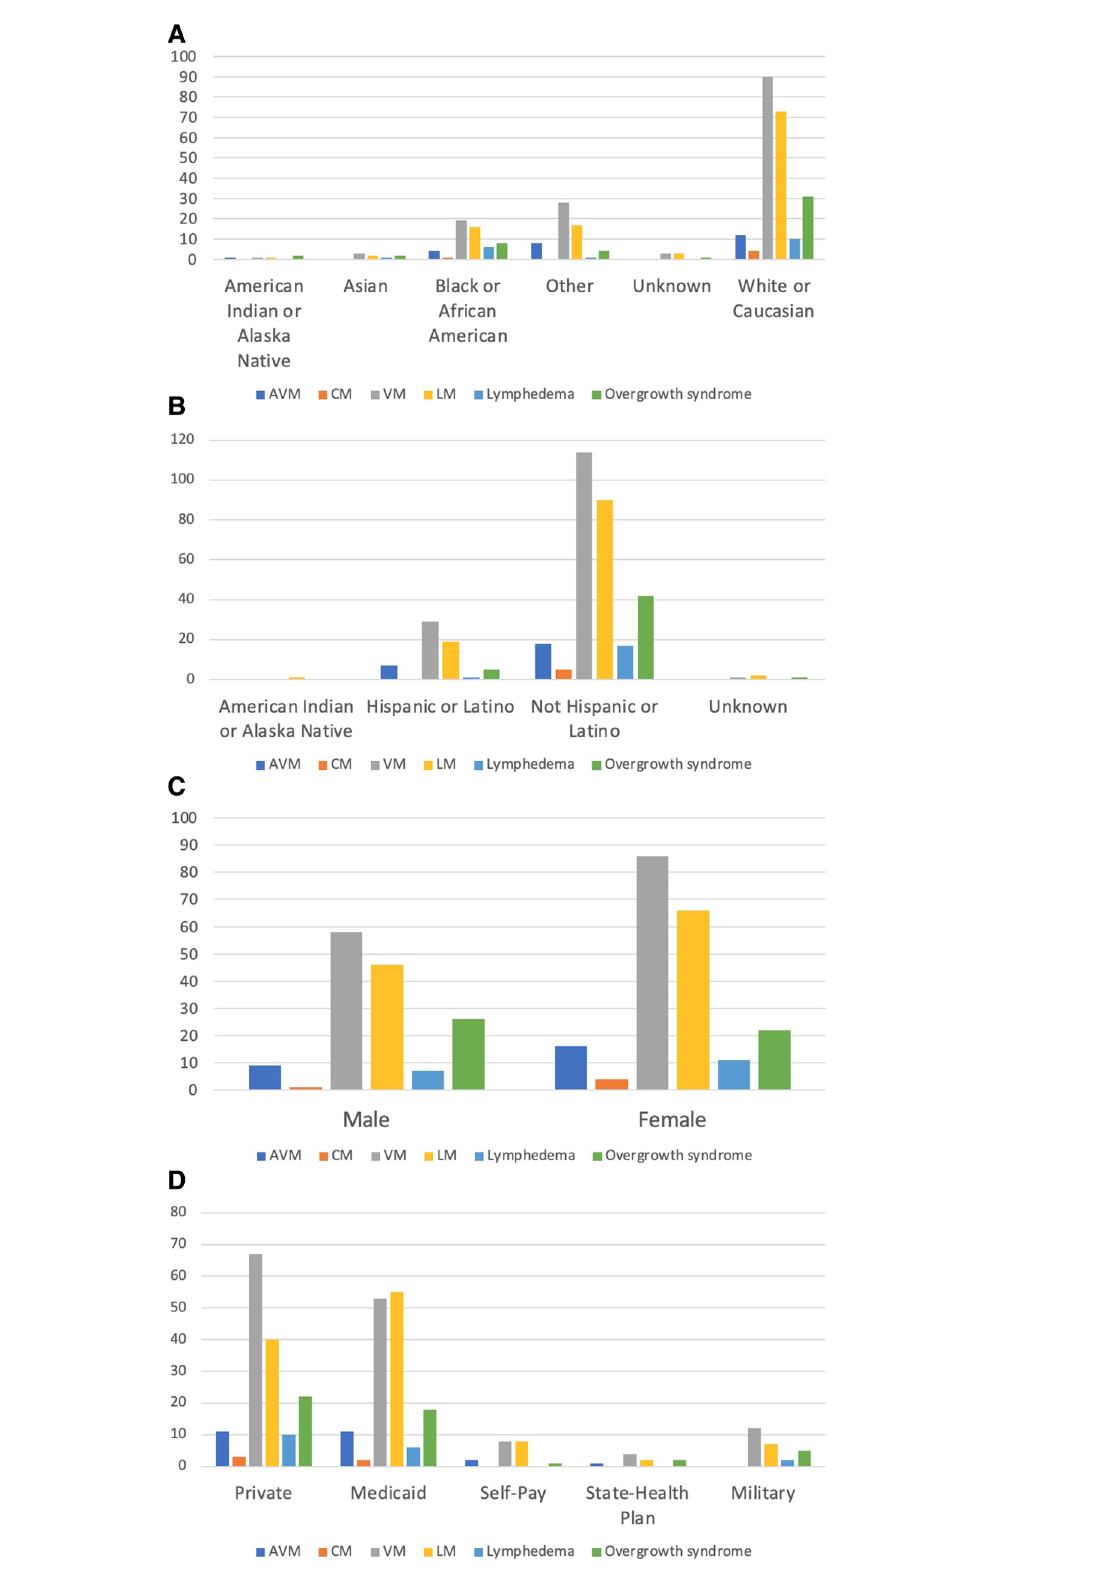
FIGURE 2 Comparison of vascular malformations by race, ethnicity, sex, and insurance. ( A ) Comparison of vascular malformations by race. ( B ) Comparison of vascular malformations by ethnicity. ( C ) Comparison of vascular malformations by sex. ( D ) Comparison of vascular malformations by insurance.